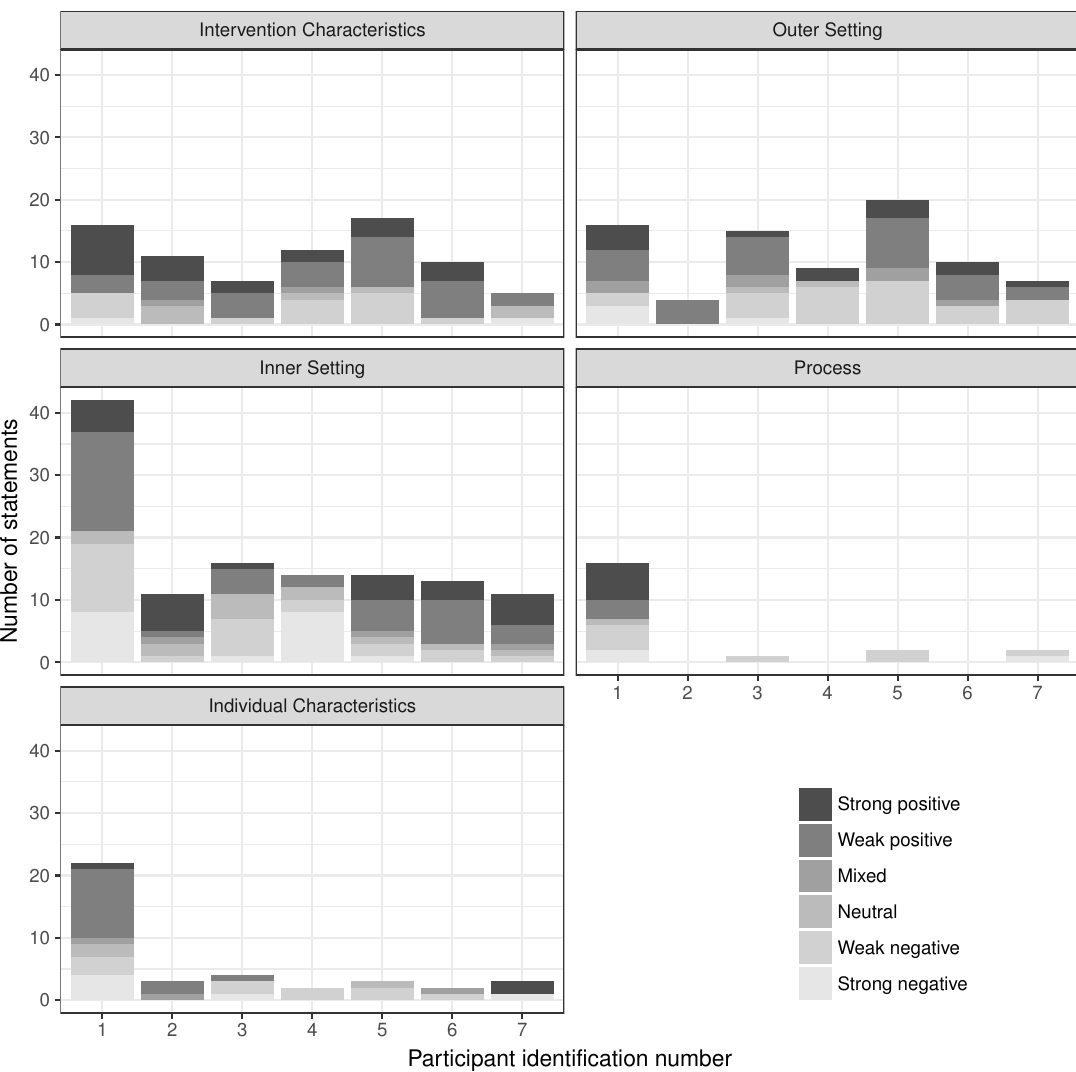
Figure 3. The number and tone of participant statements in each of the five